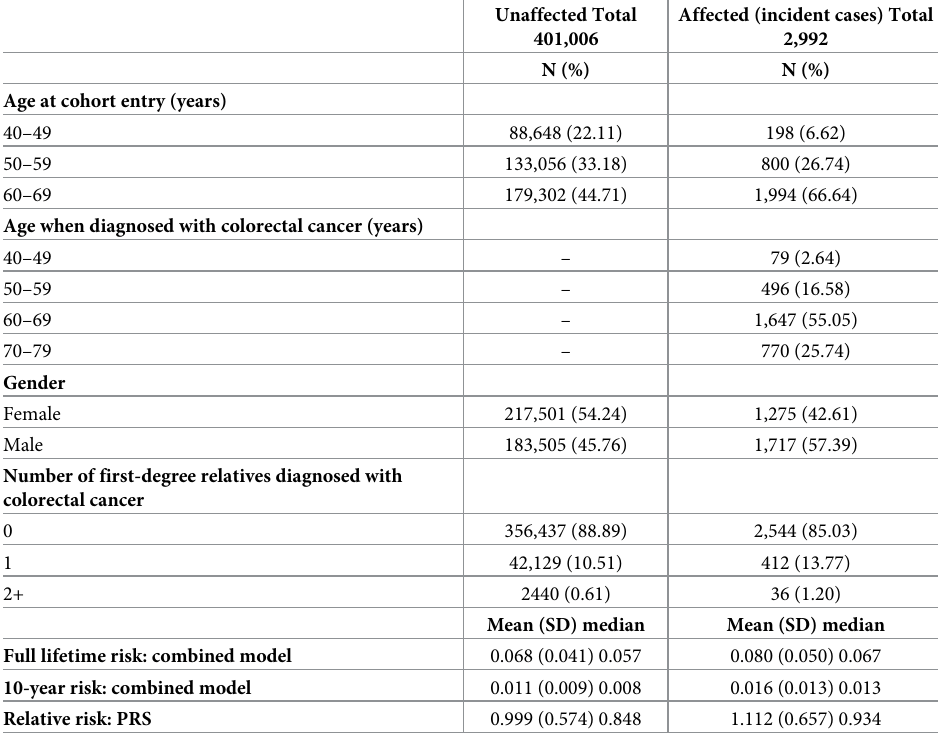
Table 2. Summary statistics for the eligible UK biobank